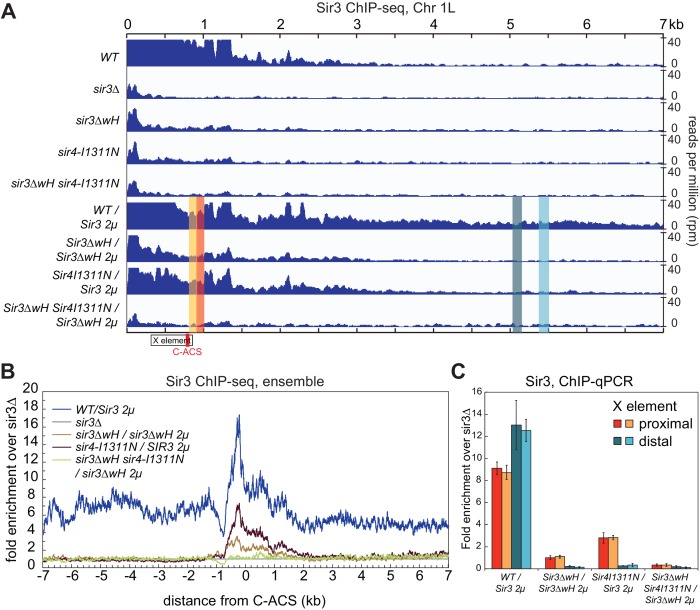
Sir3wH and Sir4CC are both required for SIR complex spreading in vivo but play partially redundant roles when Sir3 is overexpressed.(A) Normalized ChIP-seq read densities for Sir3 at the left telomere of chromosome 1 (Chr1L) from cells with the indicated genotypes. The core X element (black box) and the ACS within (C-ACS filled red box) are indicated below the tracks. Sir3 was overexpressed from a 2 micron plasmid (SIR3 2 µ). Colorshaded areas indicate regions assayed by ChIP-qPCR, shown in panel C. Full scale plots of WT and WT/Sir3 2µ strains are shown in Figure 6—figure supplement 1B. (B) Ensemble plot of Sir3 ChIP-seq signals with Sir3 overexpression, from 30 subtelomeres, excluding TEL01R and TEL13R, aligned at C-ACS. ChIP signal at all 30 subtelomeric regions was summed up, normalized to the sir3Δ sample, and plotted as a function of distance from C-ACS. Negative values are towards the chromosome end, and positive values are towards the centromere. Similar plot with endogenous Sir3 expression level is shown in Figure 6—figure supplement 1A. (C) Sir3 ChIP-qPCR results from cells with the indicated genotypes normalized to sir3∆ cells. Error bars indicate the standard deviation of three biological replicates. PCR primer sets (Table 4) were chosen to assay regions shown with corresponding colors in panel A.